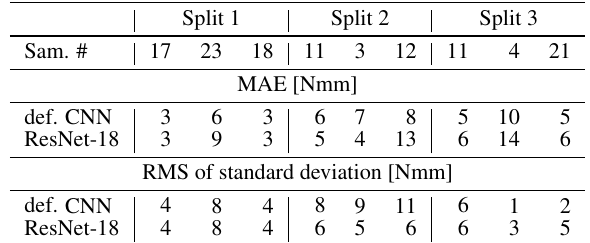
Table 2. Performance for DefaultCNN and ResNet-18 : MAE and RMS of the standard deviation of the 9 predicted support